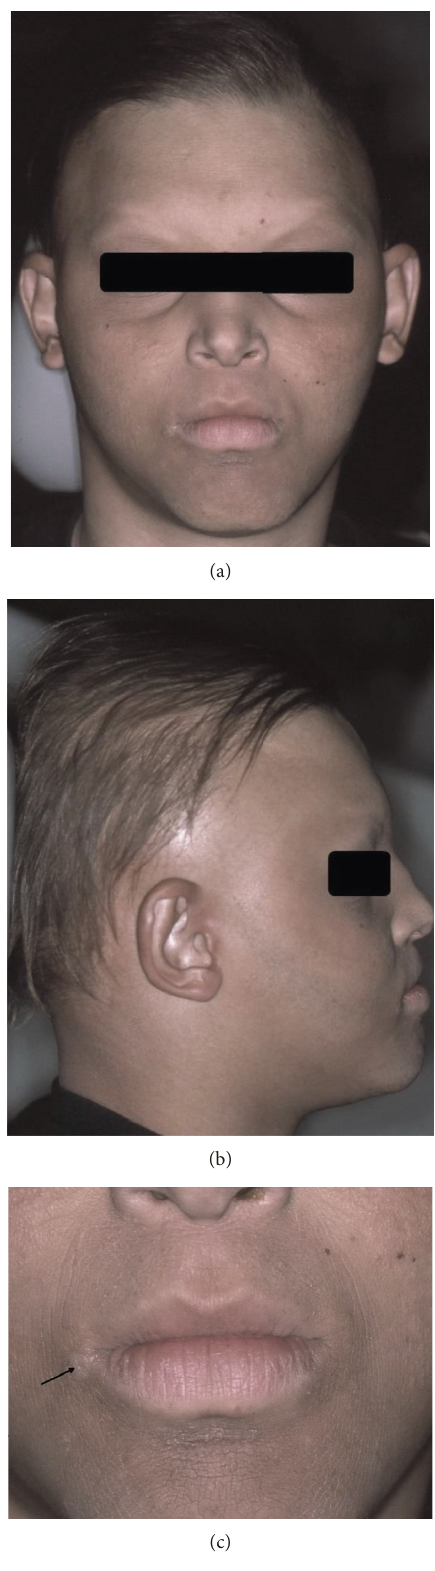
Figure 4: Patient2.BoywithhypohidroticEDdisplayingscarce,fine,and silky hair, alopecia of the eyebrows, prominent frontal bossing, discrete deformity and low implantation of the ear (a and b), angular cheilitis (arrow), dry and scaly skin, and perioral dermatitis and fissures (c).